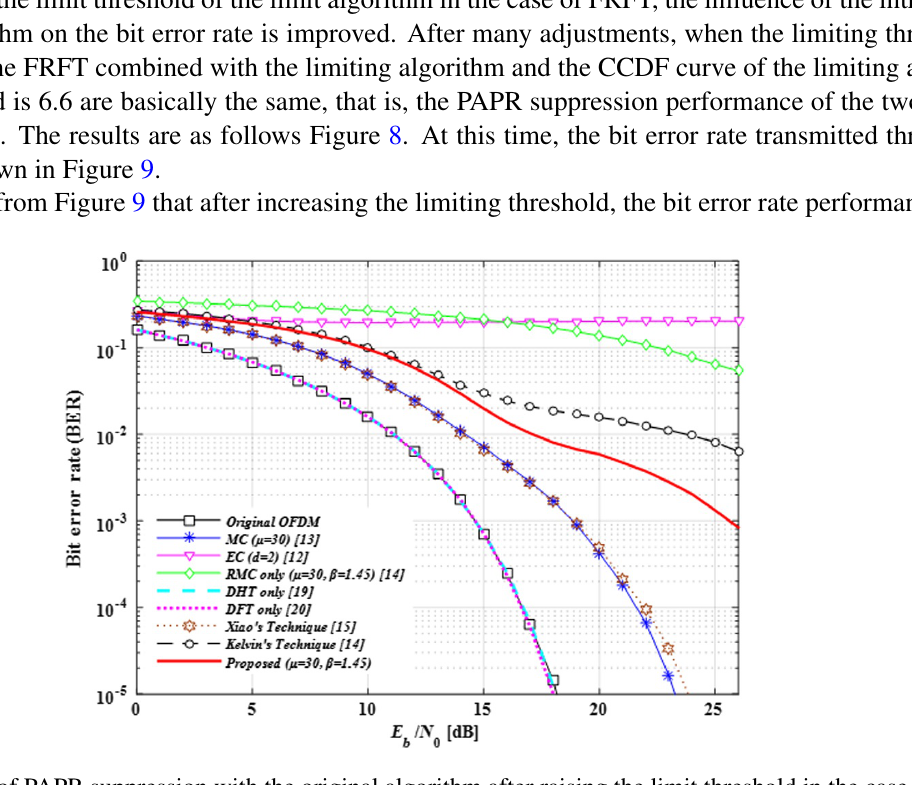
Fig. 8 Comparison of PAPR suppression with the original algorithm after raising the limit threshold in the case of FRFT. FRFT, fractional Fourier transform.